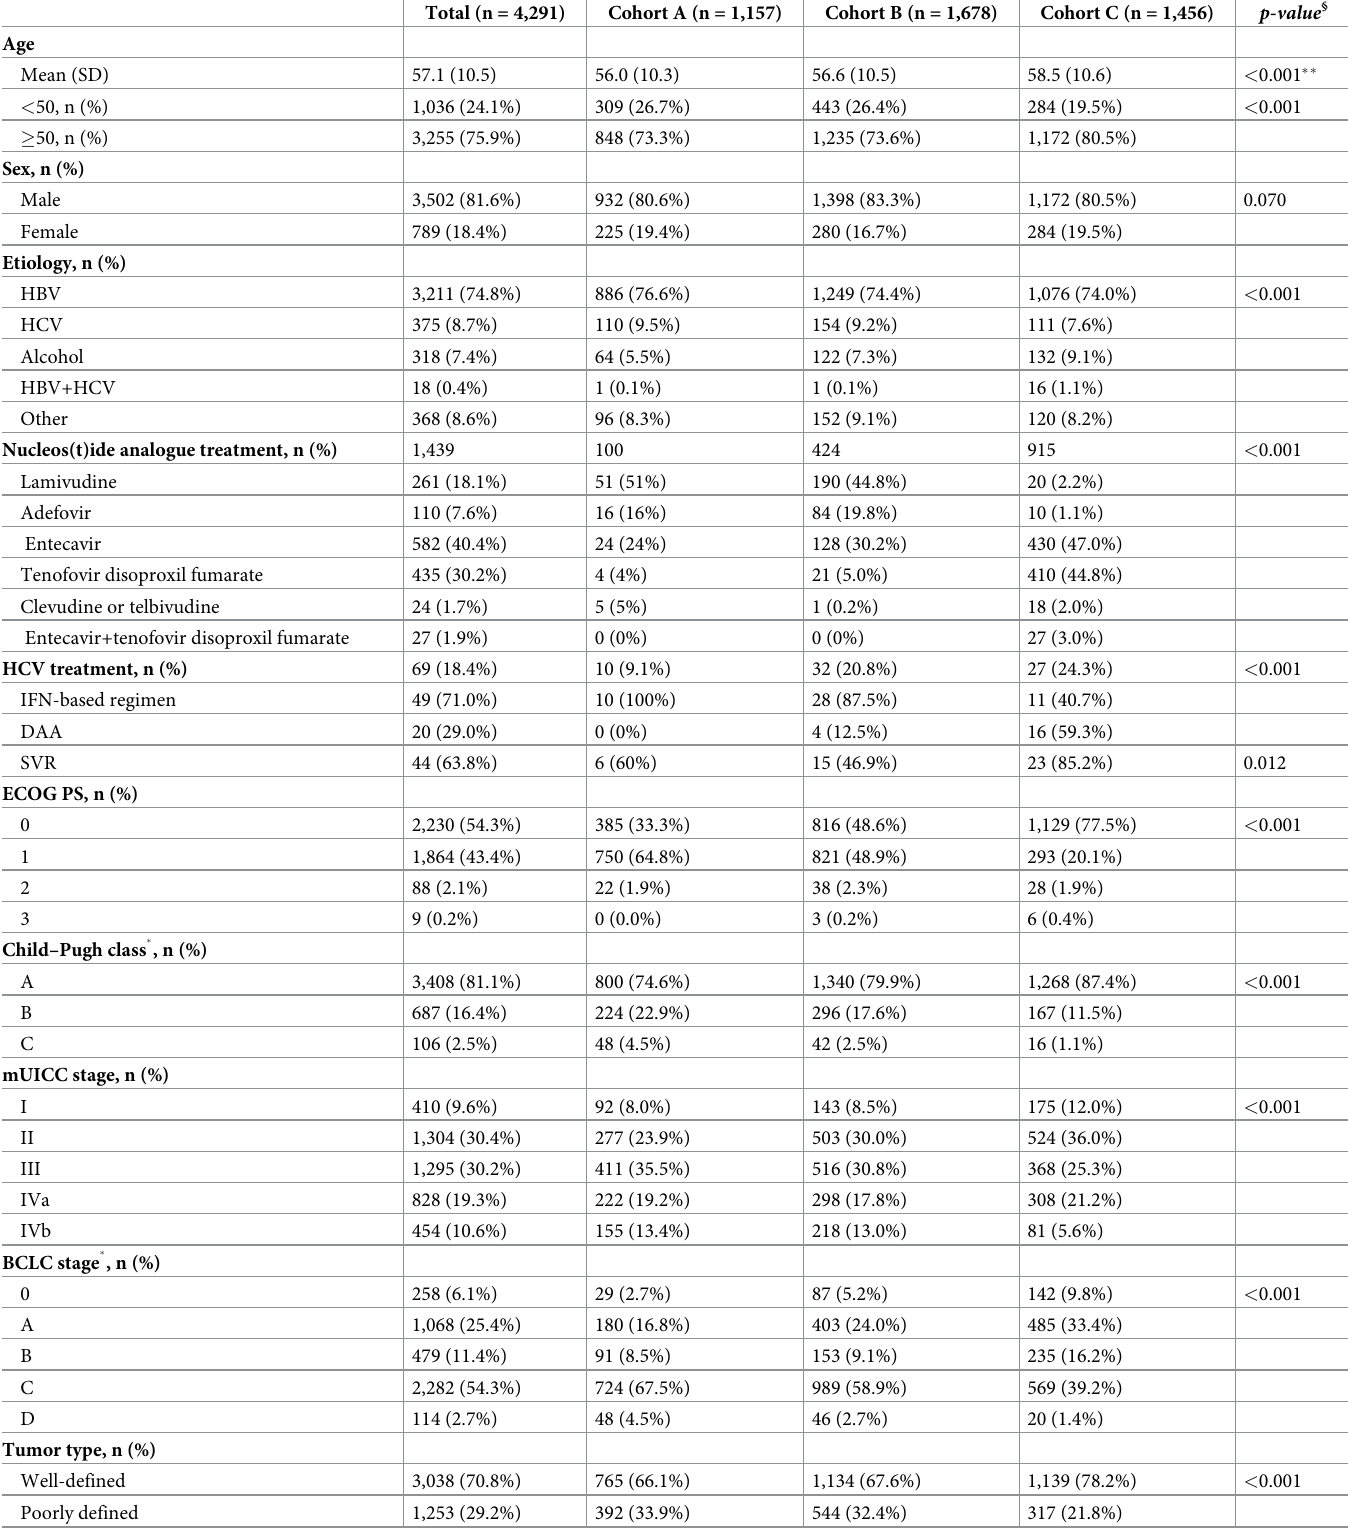
Table 1. Baseline